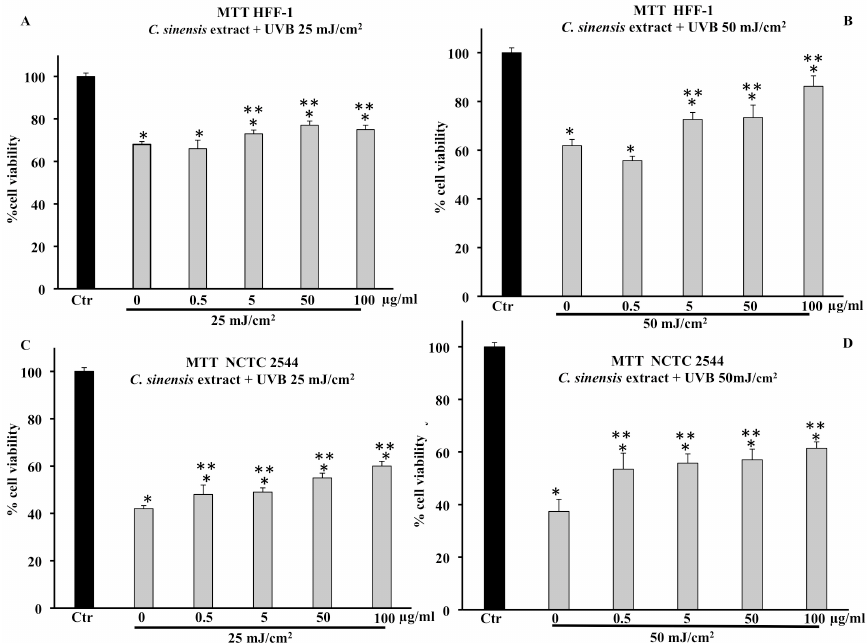
Figure 3. Cell viability in HFF-1 and NCTC 2544 cells untreated (Ctr) or treated for 4 h with C. sinensis extract at different concentrations (0.5–5–50–100 µ g/mL) and irradiated with 25 mJ/cm 2 ( A , C ) and 50 mJ/cm 2 of UVB ( B , D ). Values are the mean ± S.D. of five experiments in triplicate. * Significant vs. untreated control cells: p < 0.001; ** Significant vs. untreated irradiated cells: p < 0.001.